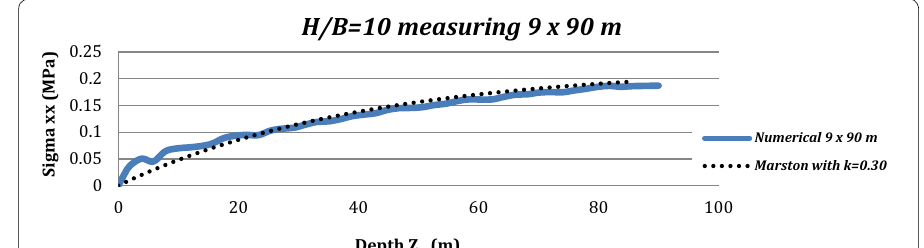
Fig. 17 Adjustment of the Marston model with backfill measuring 9 chanical parameters: φ ′